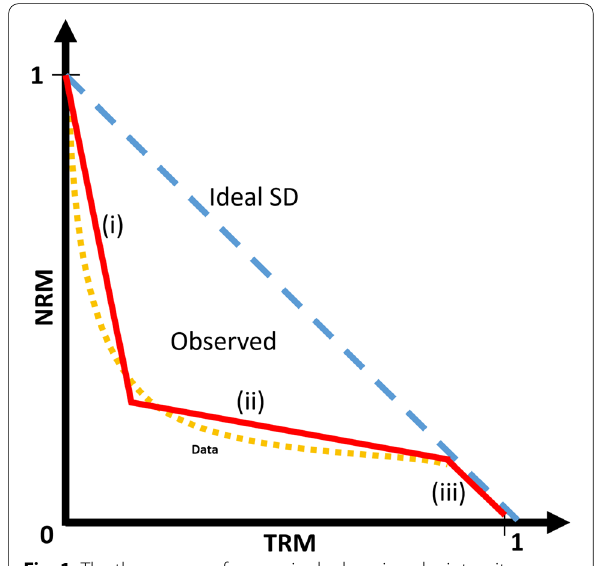
Fig. 1 The three zones of a non-single domain paleointensity experiment, taken from Hodgson et al. (2018): (i) is the lower-temperature, higher-slope (overestimating) portion, (ii) is the higher-temperature, lower-slope (underestimating) portion, (iii) is the highest-temperature, most accurate portion that this current study aims to investigate